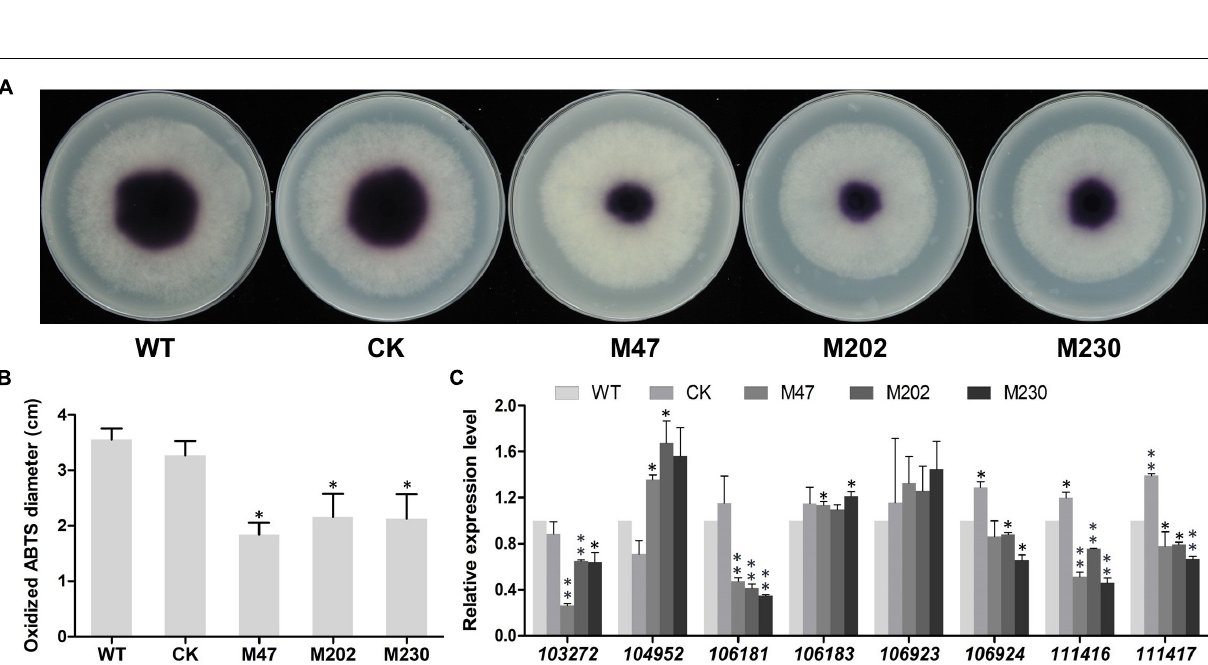
Frontiers in Plant Science |